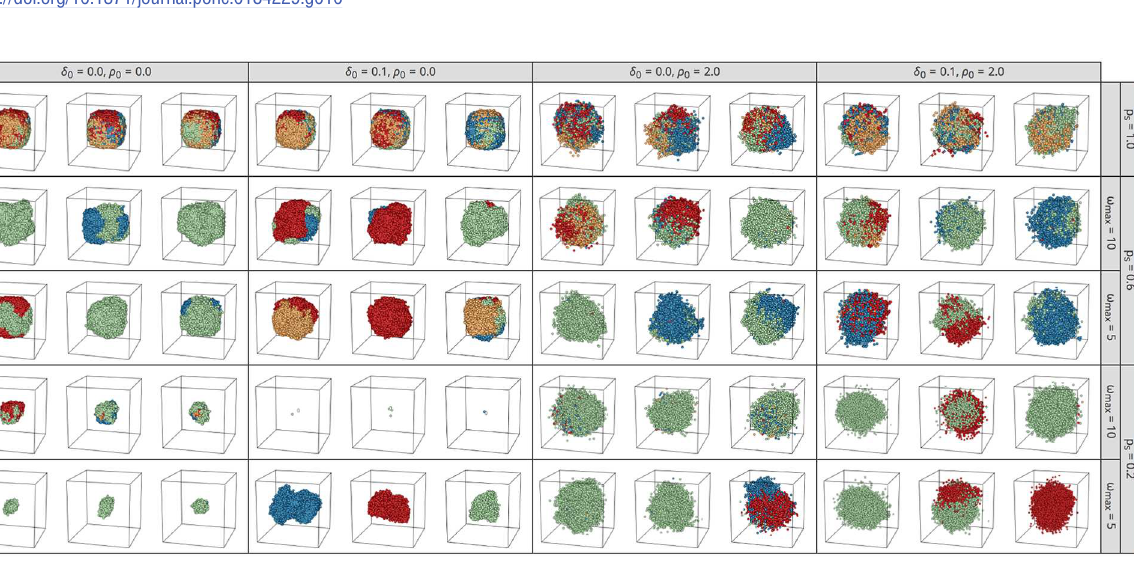
Fig 11. Effect of nonstem cells on the 3D structures of simulated tumors. Results for push method 2 under the step-function model are shown. k = 1 is assumed. Descendants from the first four cells in each simulationrun are presentedin blue, green, yellow, and red. The results of three independentruns are shown for each